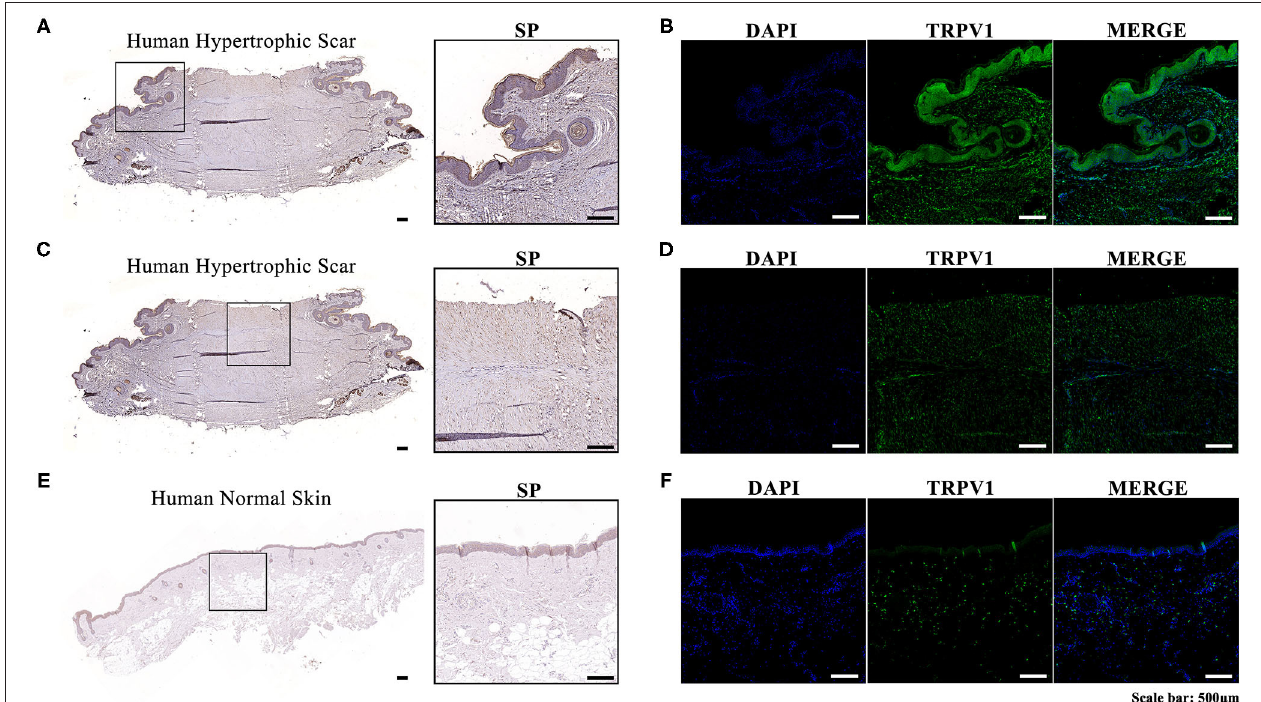
FIGURE 1 | (A) Immunohistochemistry of the expression and localization of SP along the margin and around the follicles in a human hypertrophic scar tissue sample; (B) Immunofluorescence of the expression and localization of TRPV1 along the margin and around the follicles of a human hypertrophic scar tissue sample (left, DAPI; middle, TRPV1; right, MERGE); (C) Immunohistochemistry of the expression and localization of SP in the center of a human hypertrophic scar tissue sample; (D) Immunofluorescence of the expression and localization of TRPV1 in the center of a human hypertrophic scar tissue sample (left, DAPI; middle, TRPV1; right, MERGE); (E) Immunohistochemistry of the expression and localization of SP in a human normal skin tissue sample; (F) Immunofluorescence of the expression and localization of TRPV1 in a human normal skin tissue sample (left, DAPI; middle, TRPV; right, MERGE).